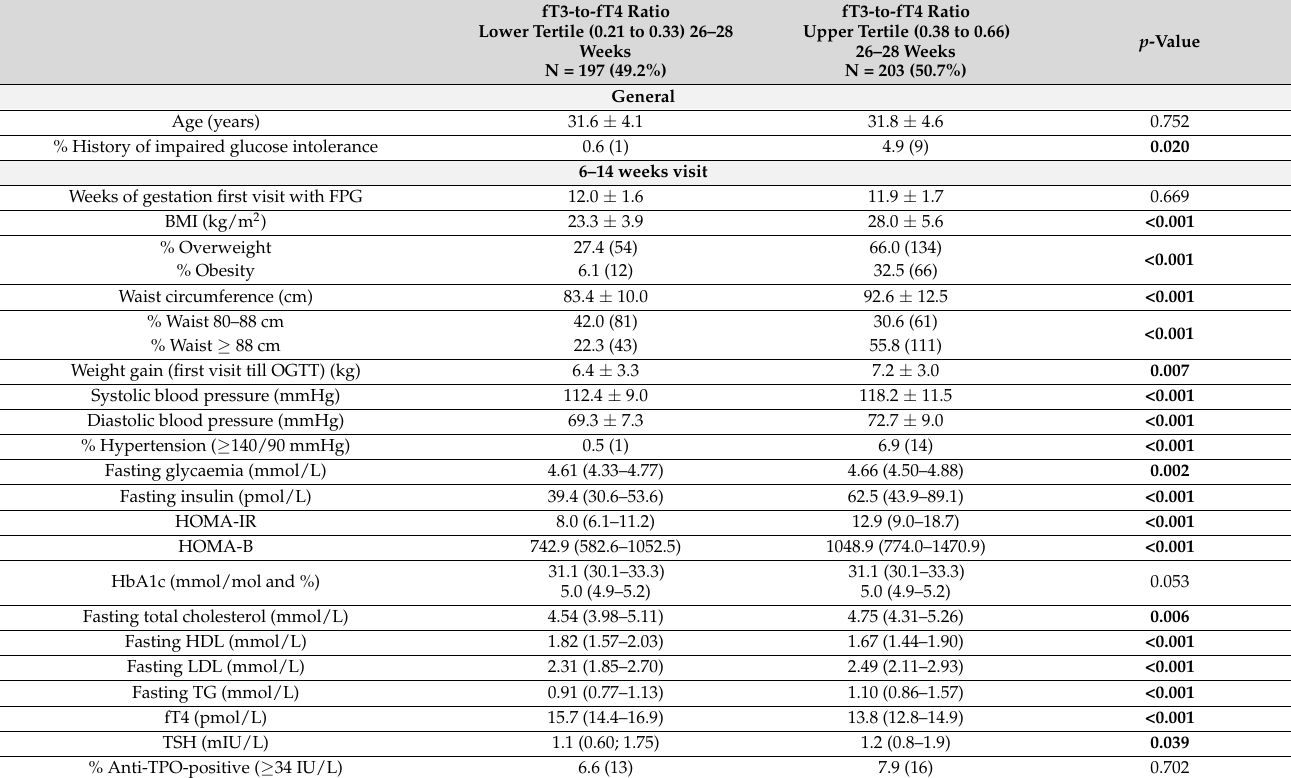
Table 5. Distribution of patient characteristics according to lower and upper tertiles of the fT3-to-fT4